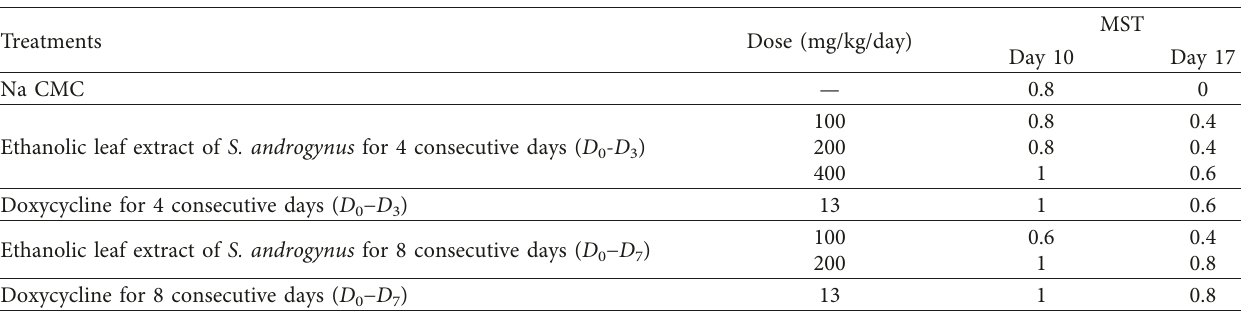
Table 6: The IC 50 values of ethanolic leaf extract of S. androgynus , chloroquine diphosphate, negative control based on the inhibition test of heme detoxification. Drug/Extract